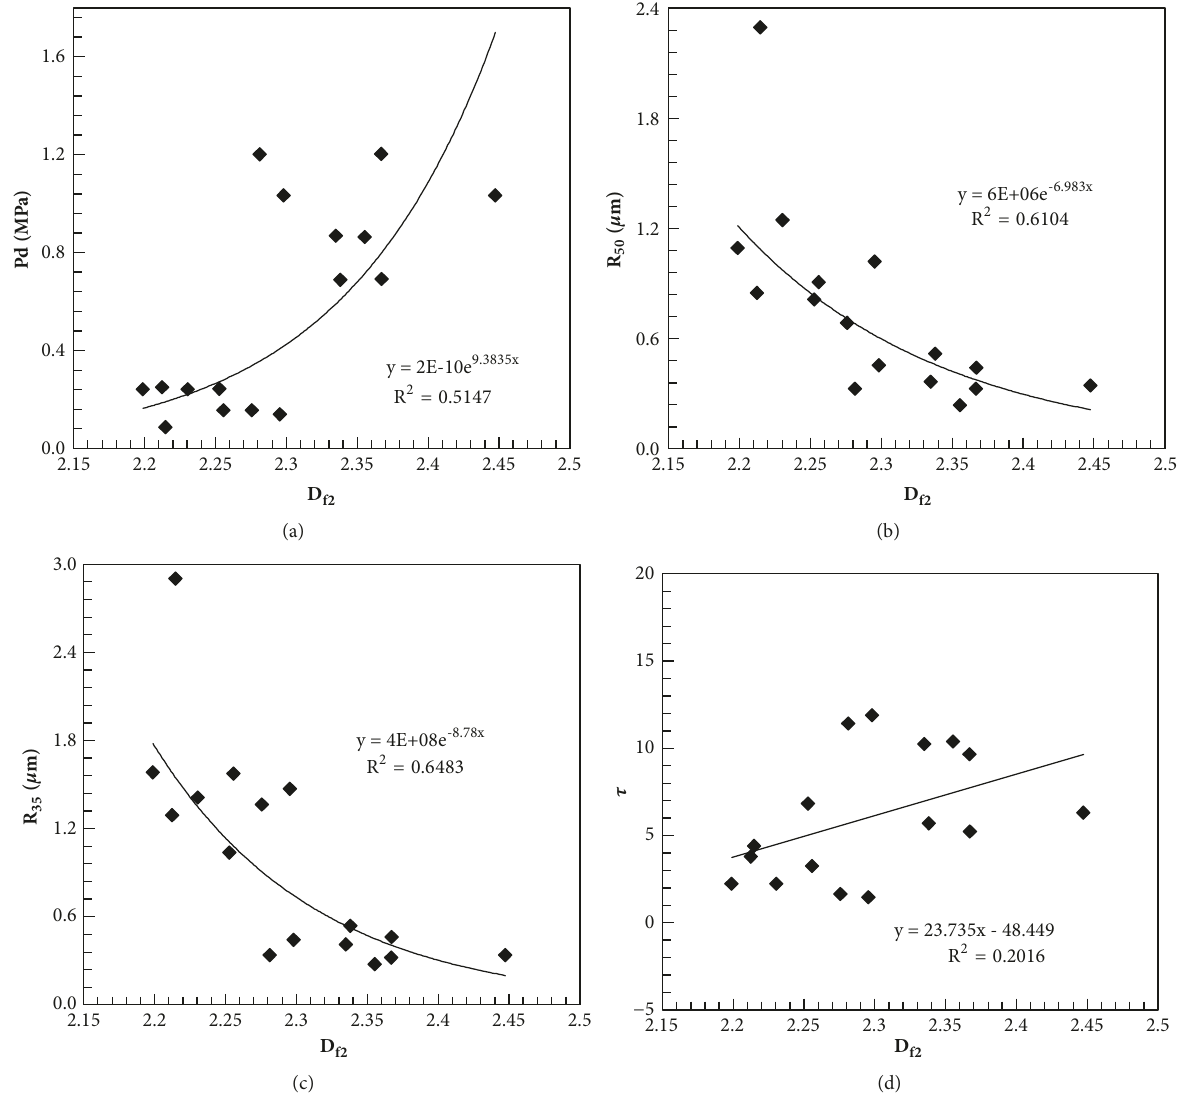
Figure 7: Relationship between fractal dimensions of the entire pores 𝐷 𝑓2 and some pore structure parameters and petrophysical properties of carbonate core samples ((a) 𝐷 𝑓2 and displacement pressure 𝑝 𝑑 ; (b) 𝐷 𝑓2 and 𝑟 50 ; (c) 𝐷 𝑓2 and 𝑟 35 ; (d) 𝐷 𝑓2 and tortuosity 𝜏